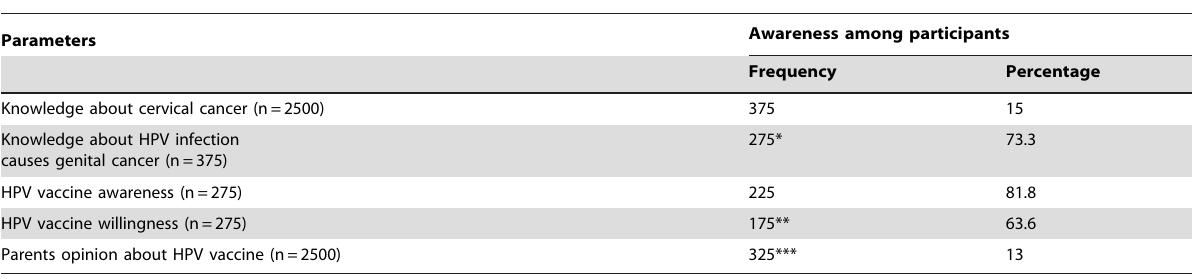
Table 2. Awareness about cervical cancer, HPV and HPV vaccine.